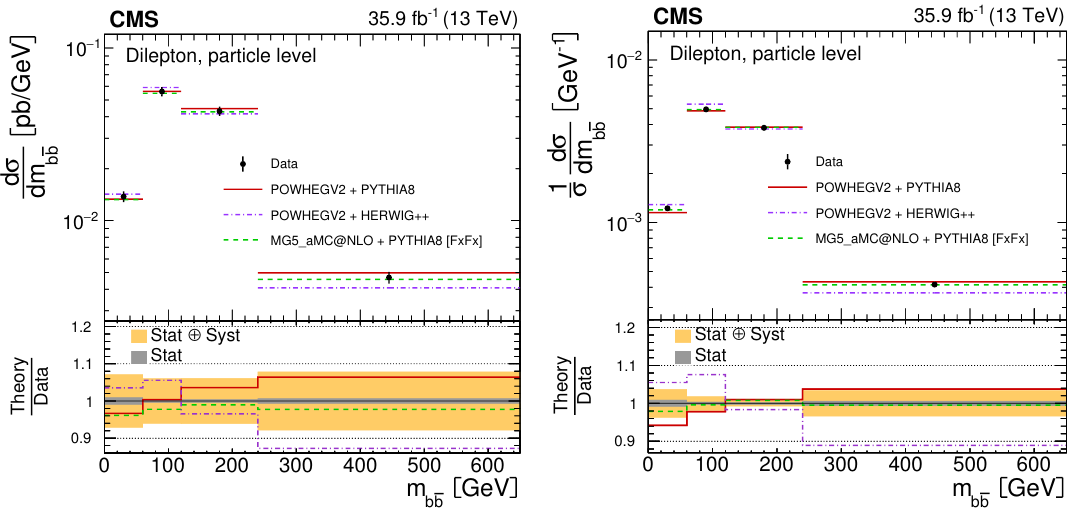
Figure 50 . The di(cid:11)erential tt production cross sections as a function of m space at the particle level are shown for the data (points) and the MC predictions (lines). The vertical lines on the points indicate the total uncertainty in the data. The left and right plots correspond to absolute and normalised measurements, respectively. The lower panel in each plot shows the ratios of the theoretical predictions to the data. The dark and light bands show the relative statistical and total uncertainties in the data, respectively.